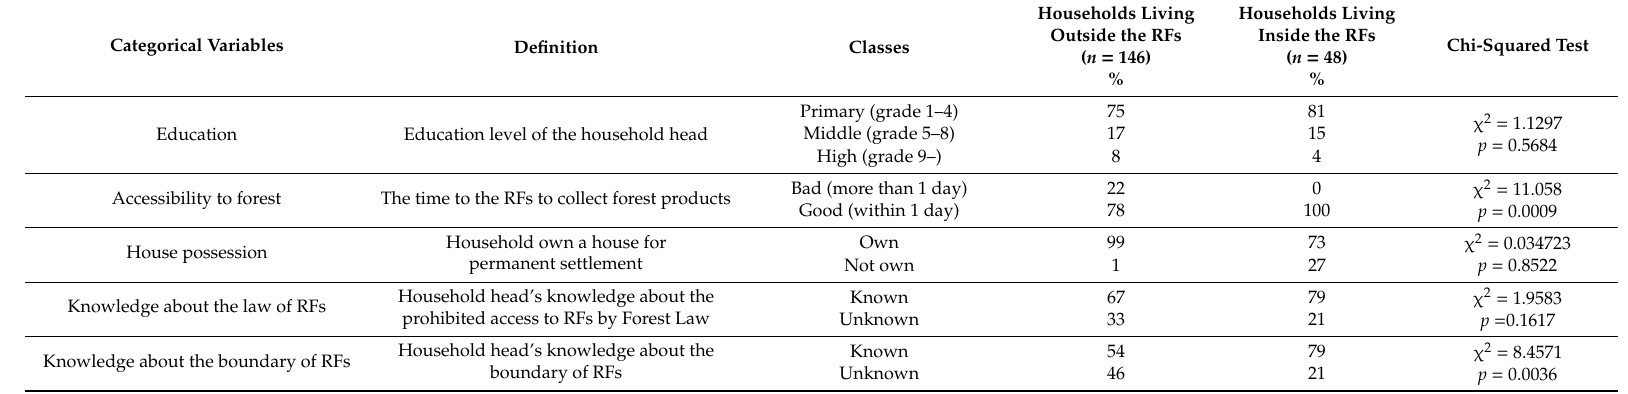
Table 3. Categorical variables of socio-economic characteristics for the sample